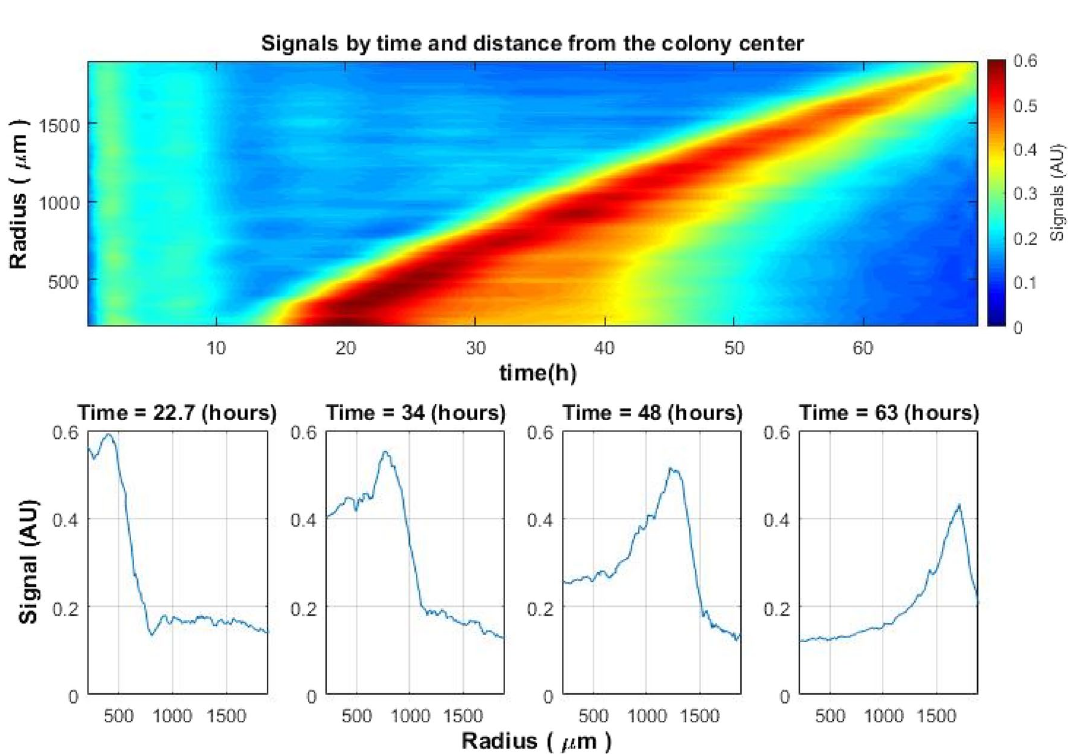
Figure 8. Envelopes of the averaged signals as a function of distance from colony center and time (top) and the peak of activity as a function of the distance from the center of the colony for different times (bottom) of S. aureus . Similar spatiotemporal behavior of the signal was observed also within colonies of E. coli and V.